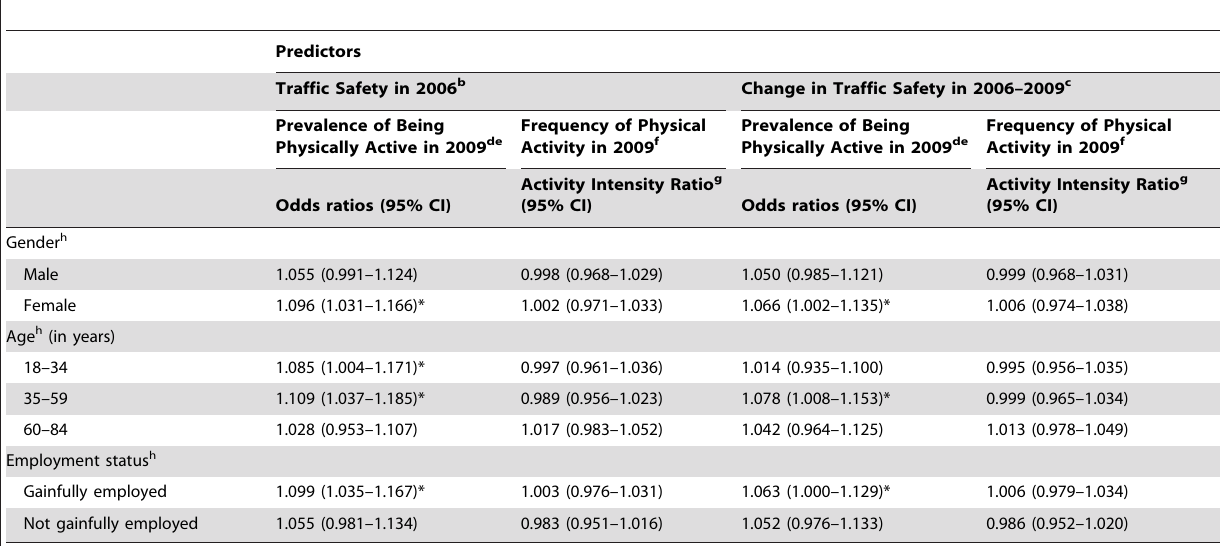
Table 5. Association of physical activity in 2009 with traffic safety in 2006 and change in traffic safety between 2006 and 2009 according to gender, age, and employment status, for 2009 respondents a